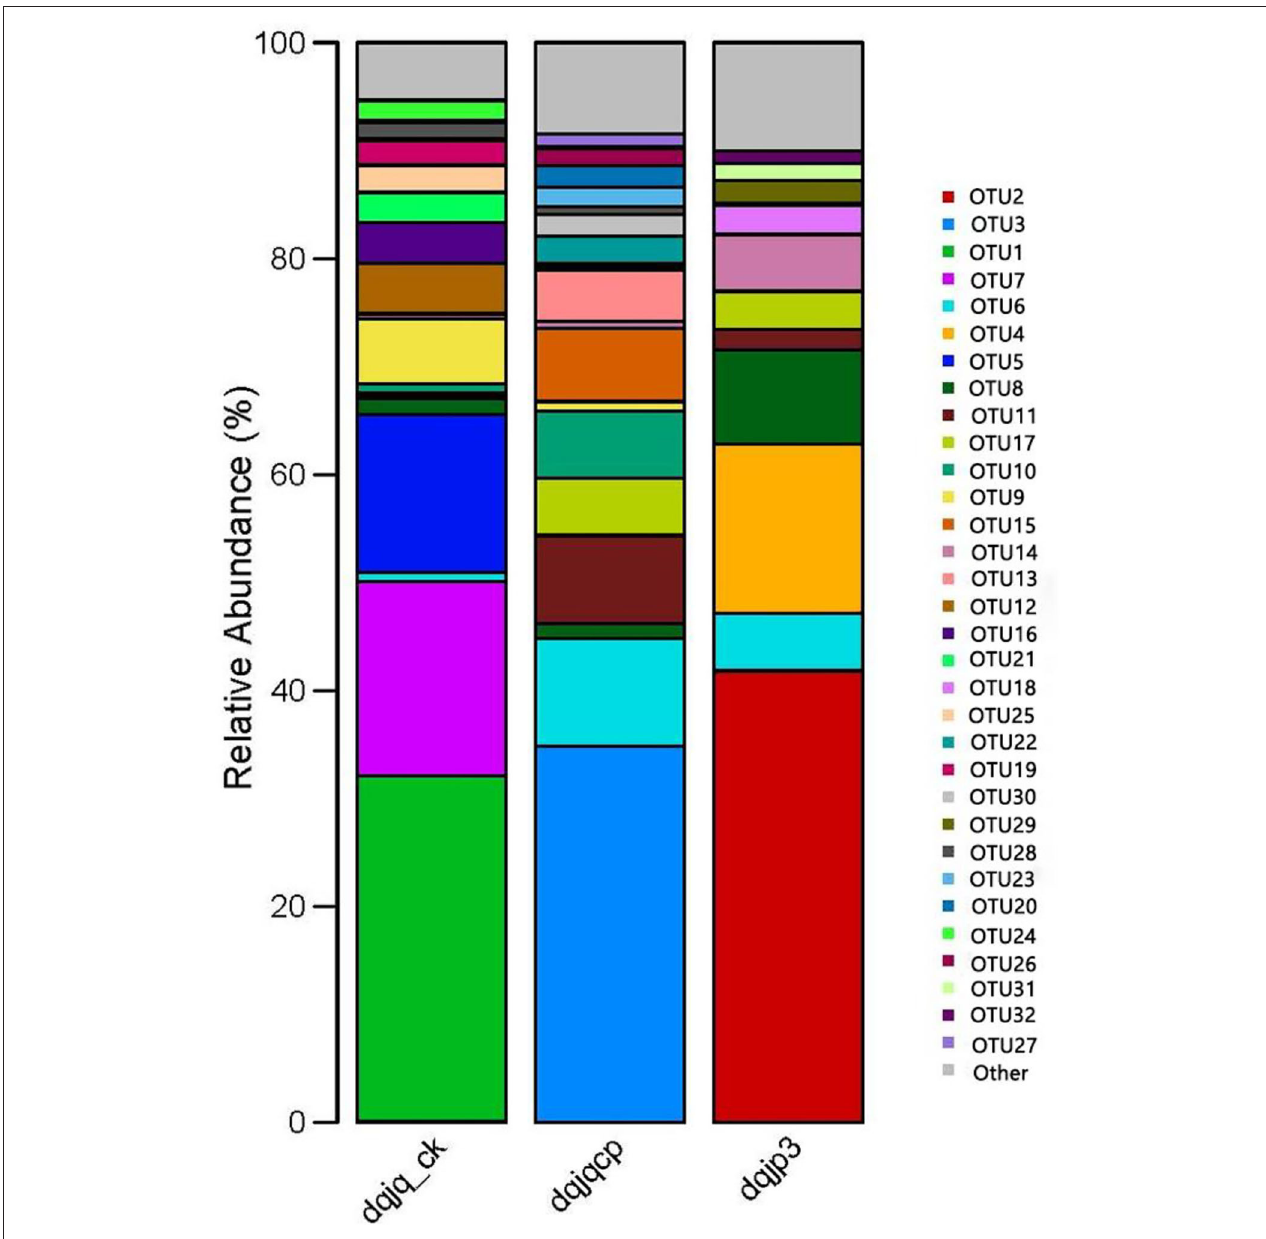
FIGURE 3 | Bacterial community in three samples at the OTU